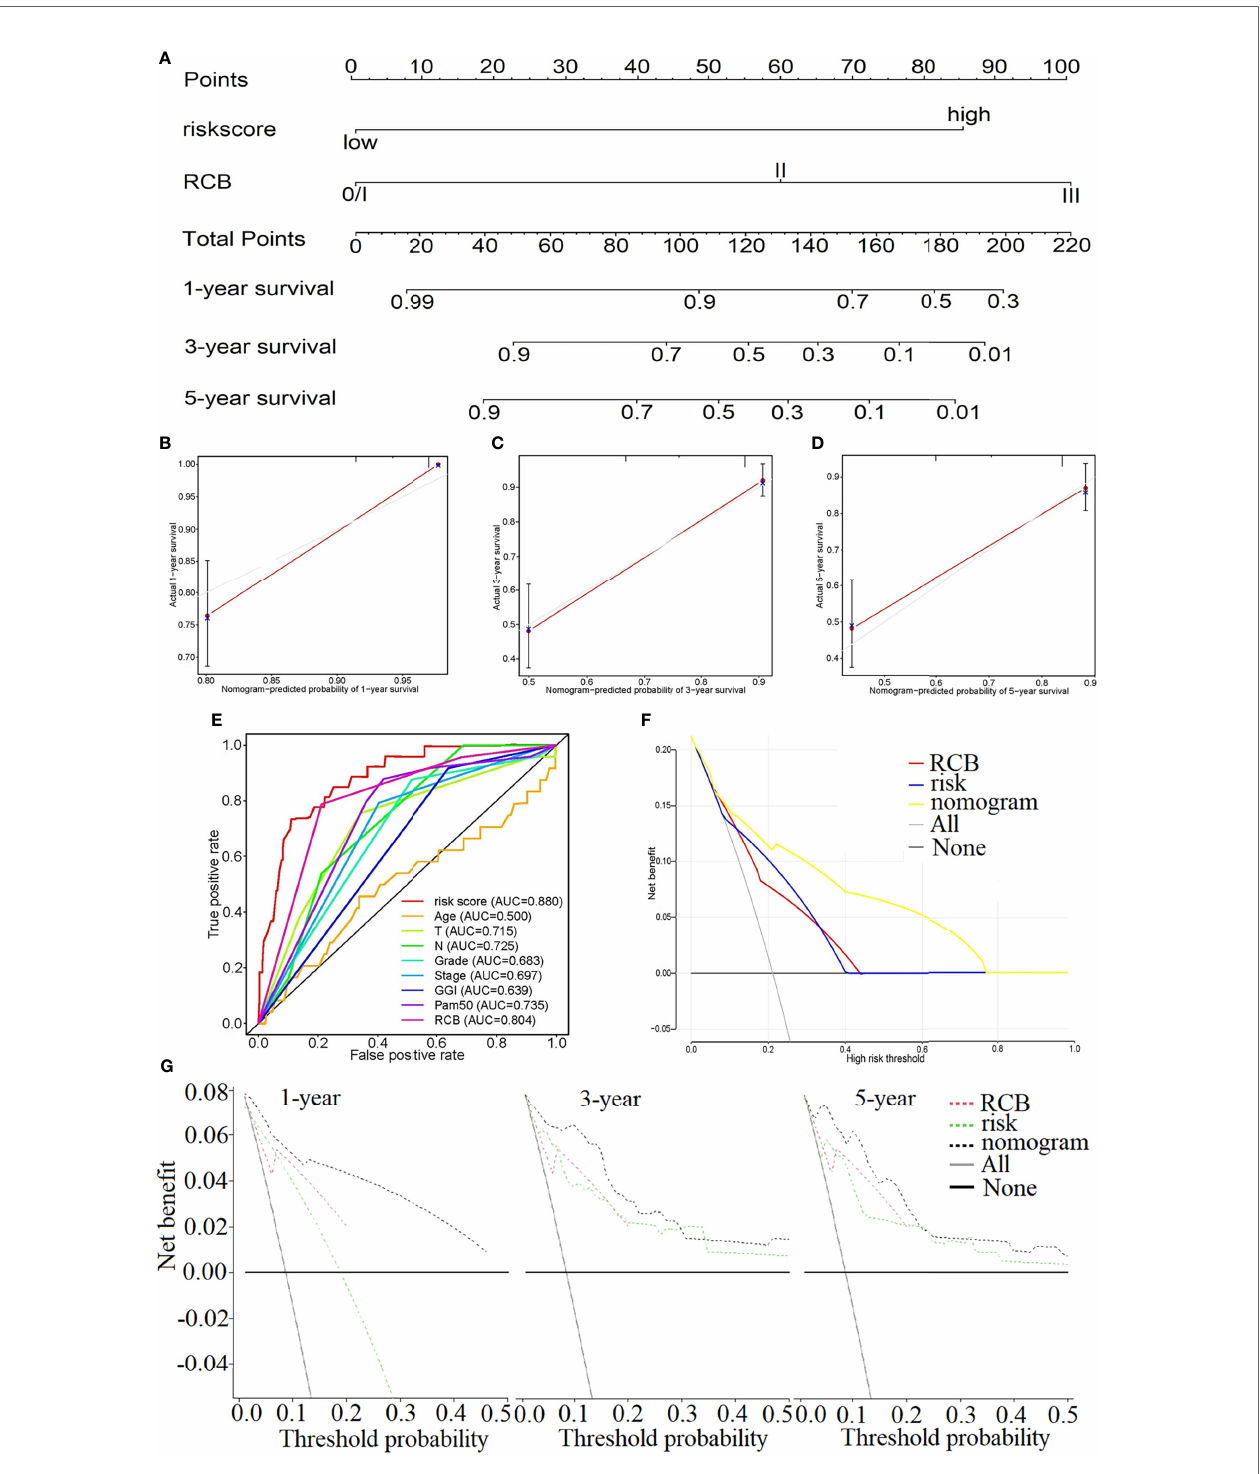
FIGURE 6 | (A) Nomogram to predict the 1-, 3-, and 5-year survival rate in GSE25055. (B – D) Calibration plots of the nomogram to predict the survival rate at 1 (B) , 3 (C) , and 5 years (D) . (E) The comparison of the ROC curve with the other clinical characteristics highlights the superiority of our risk score model. The decision curve plots of the “ nomogram ” , “ RCB ” , “ risk ” , “ All ” and “ None ” models by logistic regression (F) and Cox regression analysis (G)